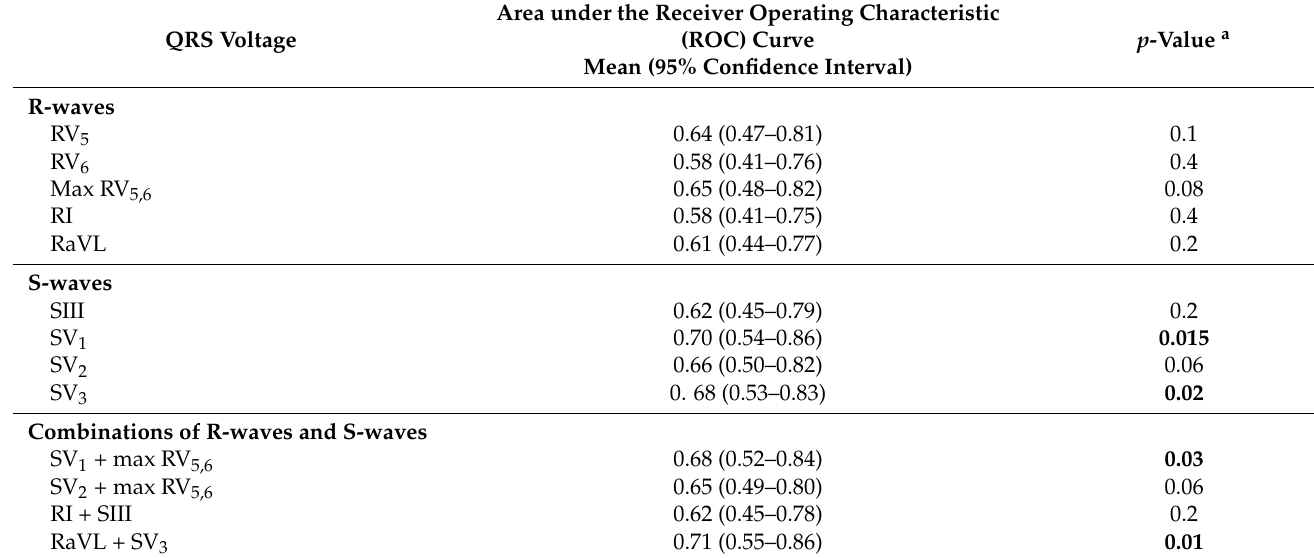
Table 3. Comparison of the discriminating ability of the voltages of the R-wave and S-wave in individual ECG leads